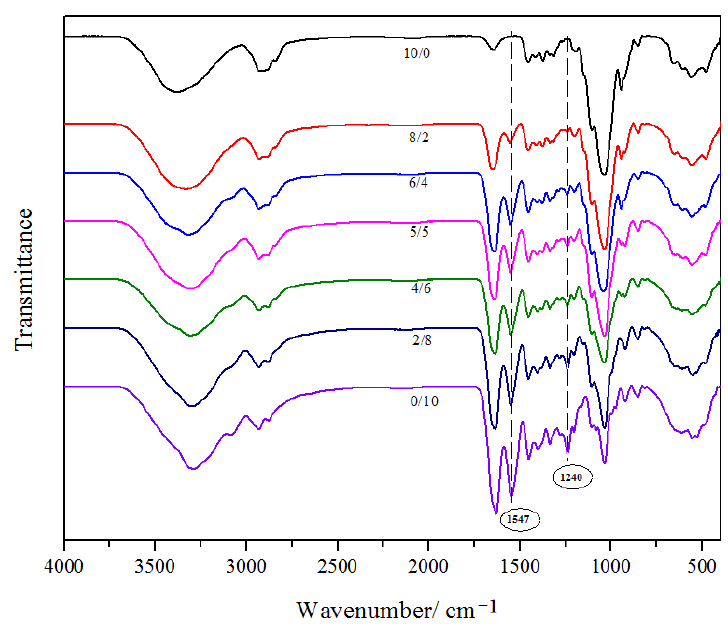
Figure 4. FTIR spectra of HPMC/Gel composite films.